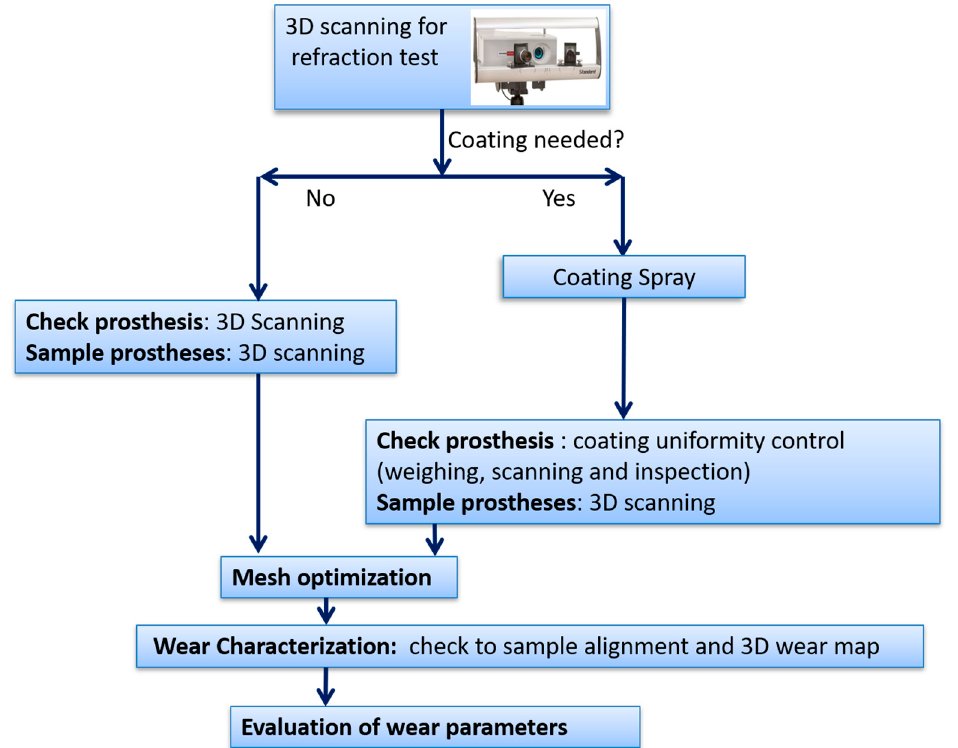
Figure 3. Wear characterization methodology flowchart.